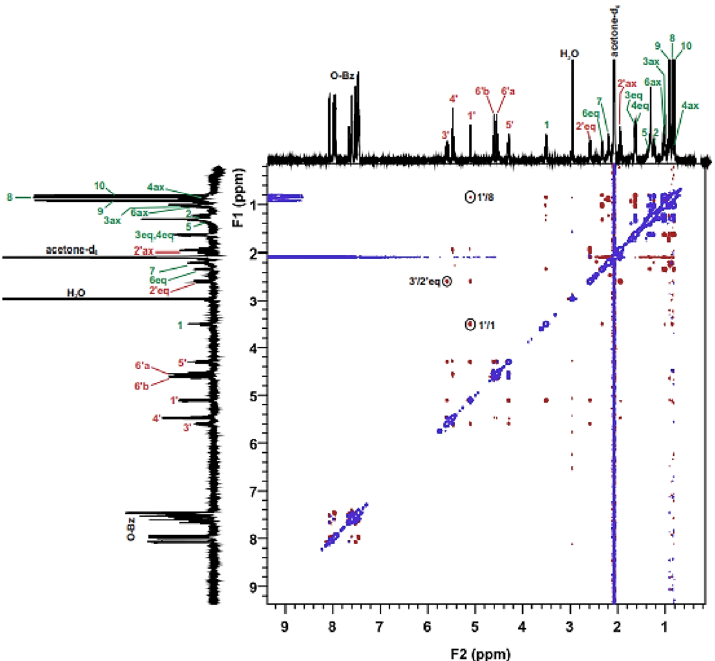
Figure 8. ROESY spectrum of molecule 1B with all dipole couplings (diagnostic signals are marked in a circle).